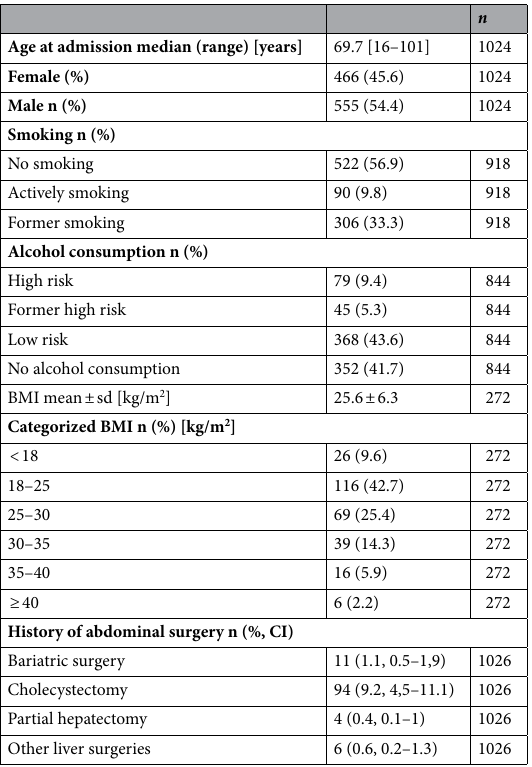
Table 1. Demographic variables of the included patient. The third column represents the number of valid (nonmissing) observations. High risk alcohol consumption: ≥ 21 unit/week for men or ≥ 14/week for women. Low risk alcohol consumption: < 21 unit/week for men or < 14/week for women. BMI: body mass index.